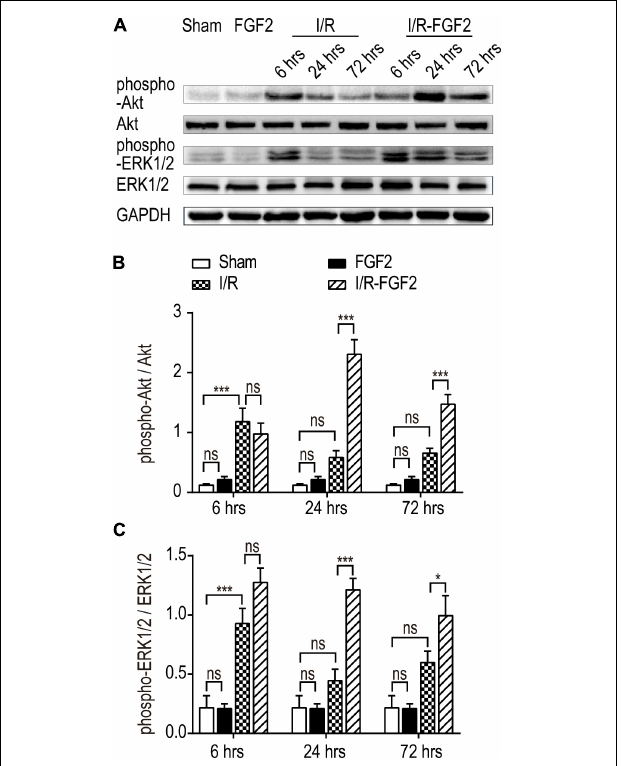
FIGURE 5 | The effect of FGF2 on the phosphorylation of Akt and ERK1/2. (A) The phosphorylation of Akt and ERK1/2 was determined by immunoblot analysis. GAPDH was used as a loading control. Images are representative of five animals in each group. (B,C) The histograms show the normalized optical density analysis. The phosphorylation of Akt and ERK1/2 in the I/R group was transiently increased at 6 h after reperfusion compared to the Sham group, whereas there was no significant difference between the I/R group and the Sham group at 24 and 72 h. FGF2 treatment strikingly increased the phosphorylation of Akt and ERK1/2 at 24 and 72 h after reperfusion compared to the I/R group. Representative data of five individual samples in each group. * P < 0.05, ** P < 0.01, *** P < 0.001; ns indicates not statistically